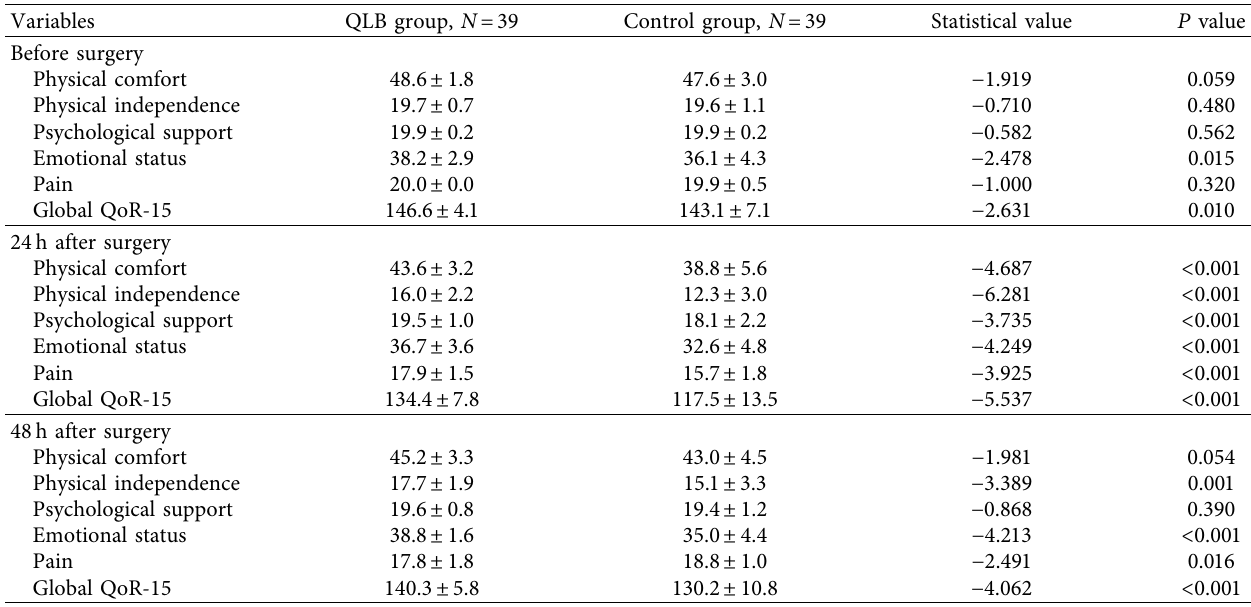
Table 2: QoR-15 questionnaire global and dimension scores.